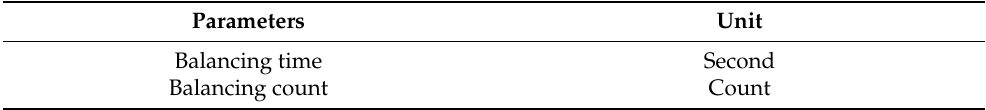
Table 1. Key parameters traced during balancing process.